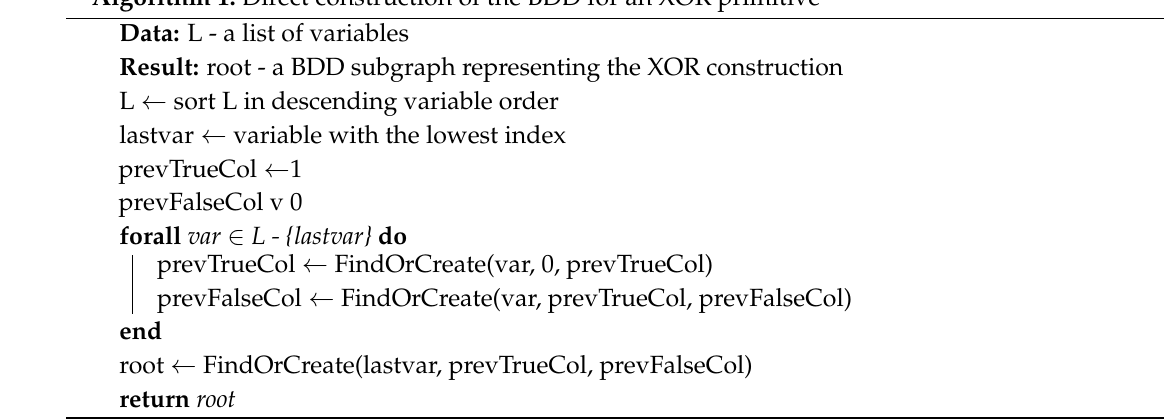
Algorithm 1: Direct construction of the BDD for an XOR primitive Data: L - a list of variables